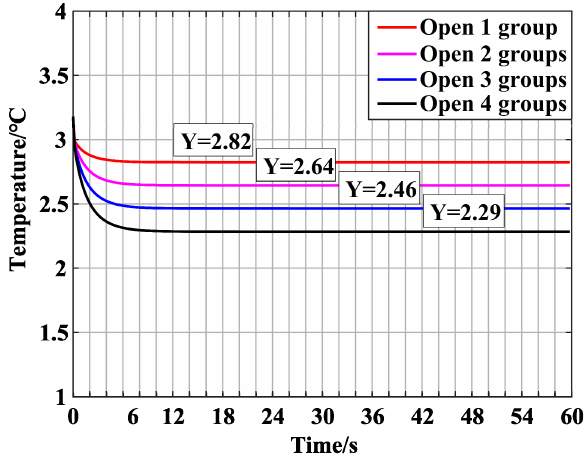
Figure 12. Simulation image of temperature compensation of semiconductor refrigeration plates.